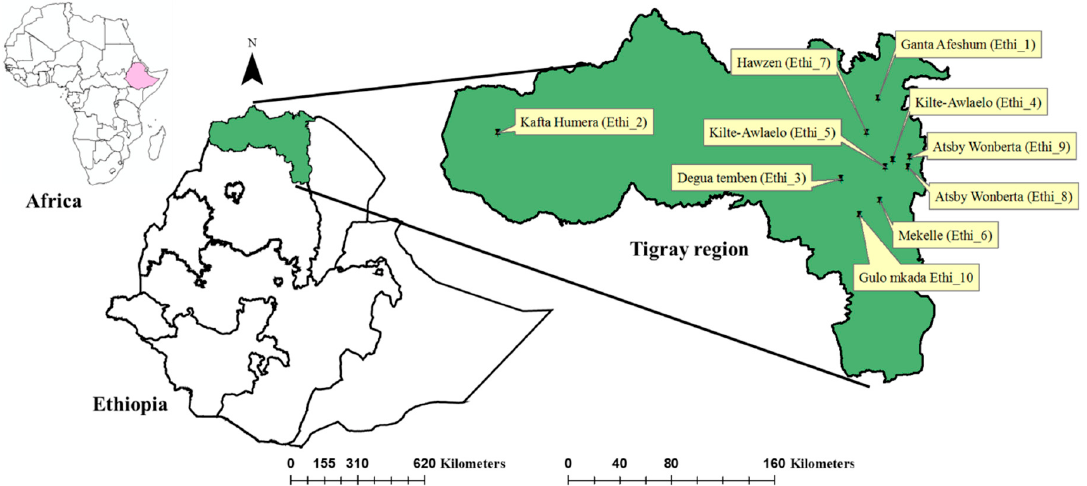
Figure 1. Map of Ethiopia in the horn of East Africa (see left window; Ethiopia is colored pink). The selected apiary sites in the Tigray National Regional State of Ethiopia (in green) are marked, and their sample codes are given (Ethi_1 to Ethi_10).